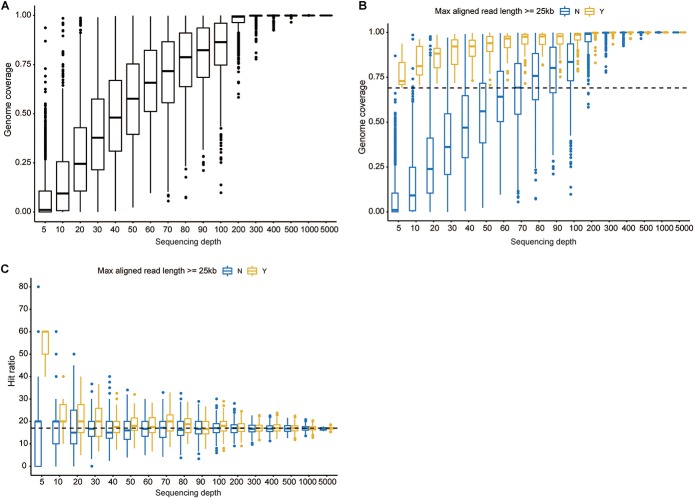
Investigation of the minimal read number to identify the current isolate. (A) The overall genome coverage distribution when 5–5,000 reads were randomly selected. The x axis denotes pseudosequencing depth, and the y axis, the corresponding genome coverages. (B) Genome coverage distribution decomposed by the maximal aligned read length. The dashed line corresponds to 69.10%. (C) Hit ratio distribution decomposed by the maximal aligned read length. The dashed line corresponds to 16.92%. “Y” represents read length being more than 25 kb, and “N” indicates less than 25 kb. Boxes represent the interquartile range (IQR) between the first and third quartiles (25th and 75th percentiles, respectively). Lines inside denote the median, and whiskers denote the most extreme values within 1.5 times IQR from the first and third quartiles. Outlier values are represented as points.